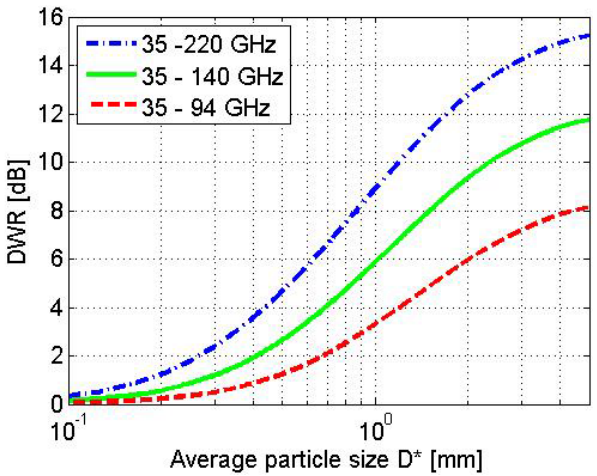
Figure 9. Dual-wavelength ratio as a function of average particle size computed for various pairs of